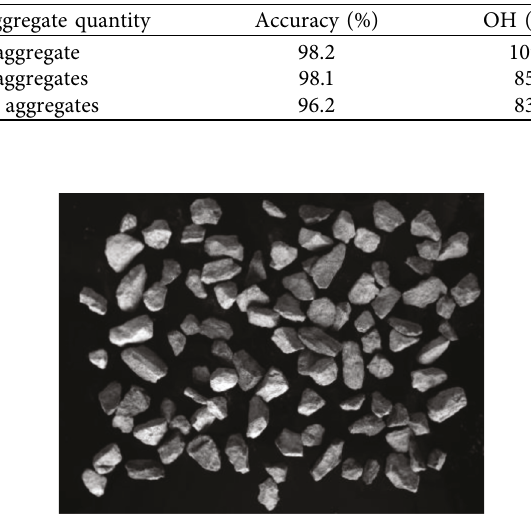
Figure 6: 9.5-13.2mm indoor spreading image.